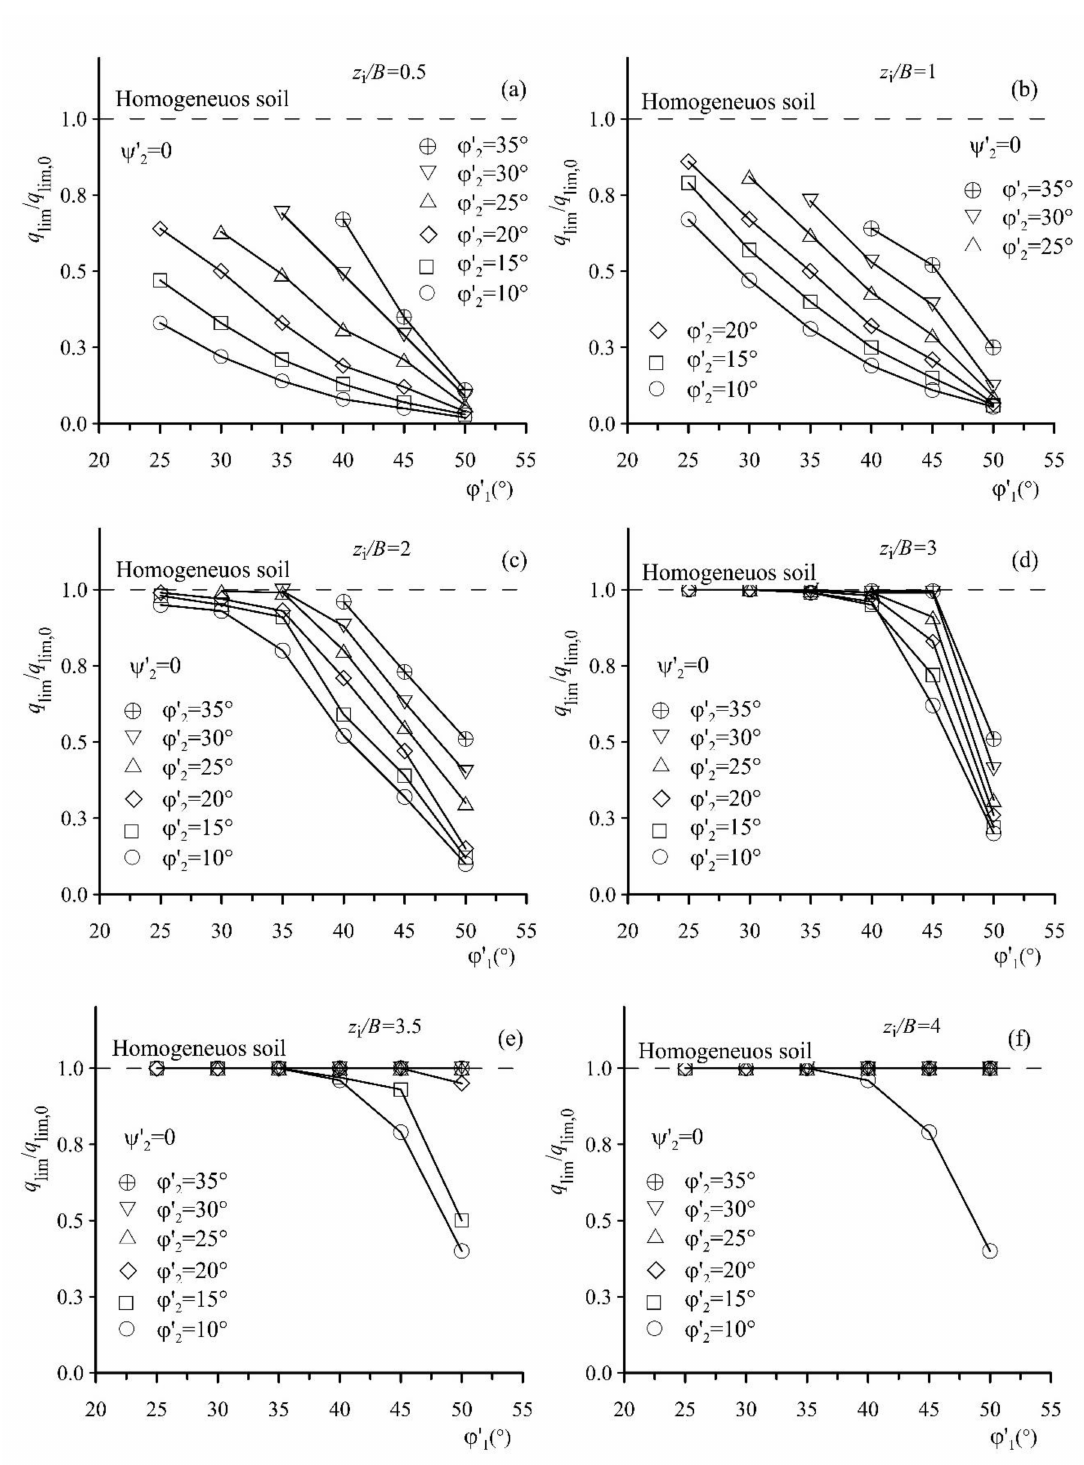
Figure 13. Normalised bearing capacity q lim /q lim,0 as a function of the shear strength angle ϕ (cid:48) 1 of the foundation soil for different values of the shear strength angle of the weak layer ϕ (cid:48) 2 and of the normalised depth of the weak layer z i